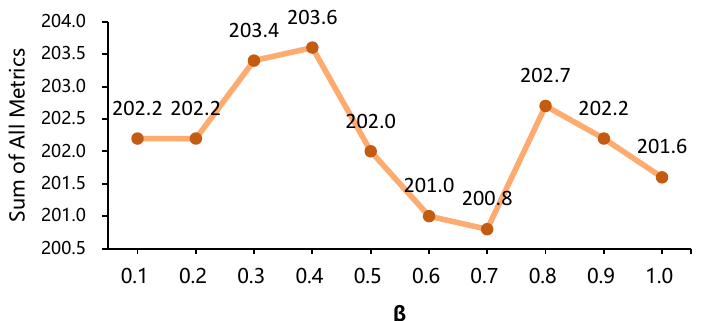
Figure 5. Experimental results of the hyperparameter of multi-task. Use the sum of all metrics as the overall metric. A larger value is better.